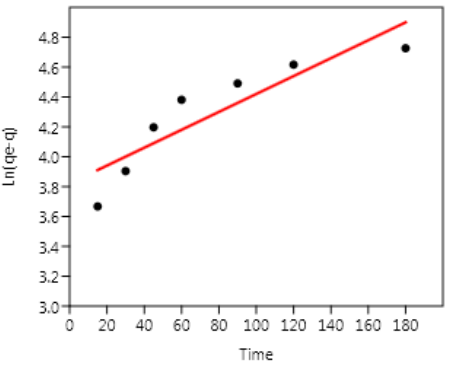
Figure 9. The pseudo-kinetics of the adsorption of phos- phate by chitosan-activated carbon nanocomposite